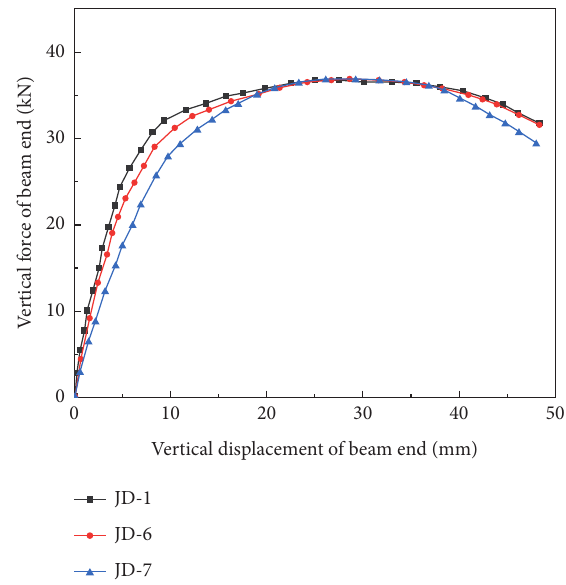
Figure 16: The skeleton curves of different sleeve